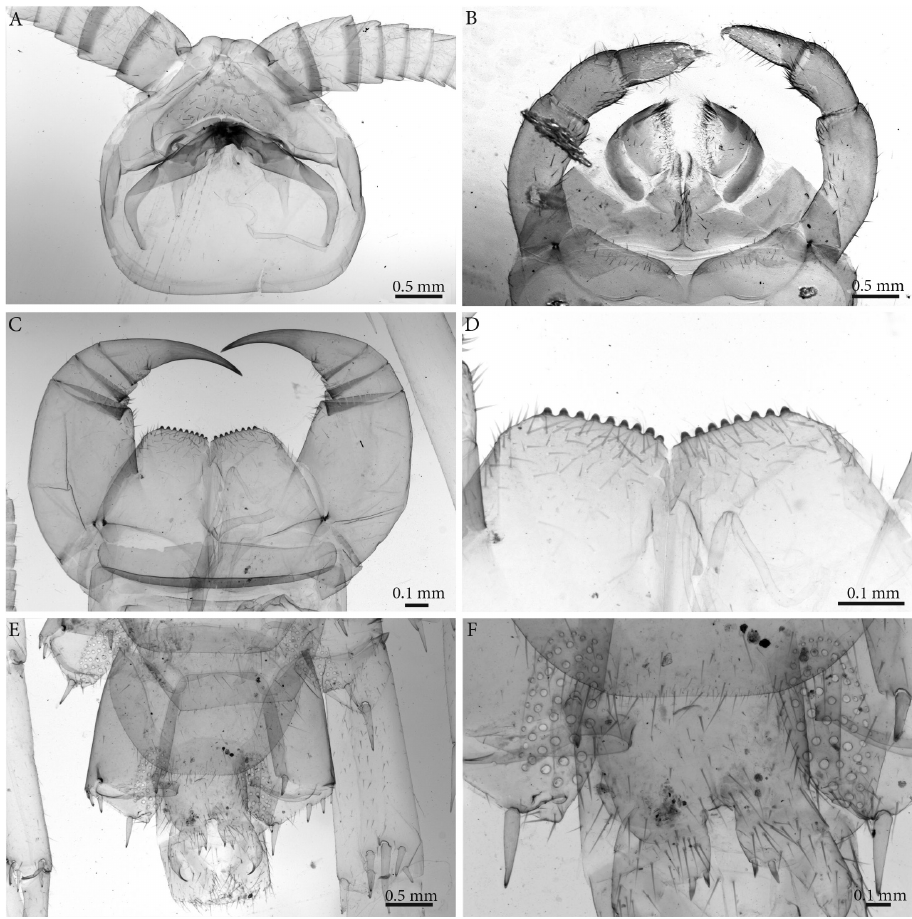
Figure 10. E. wardaranus , female syntype. A Cephalic plate ventral showing clypeus and mandibles B Maxillae C Forcipular coxosternum D Close-up of the tooth plate E , F Terminal segments and geni- talia, ventral